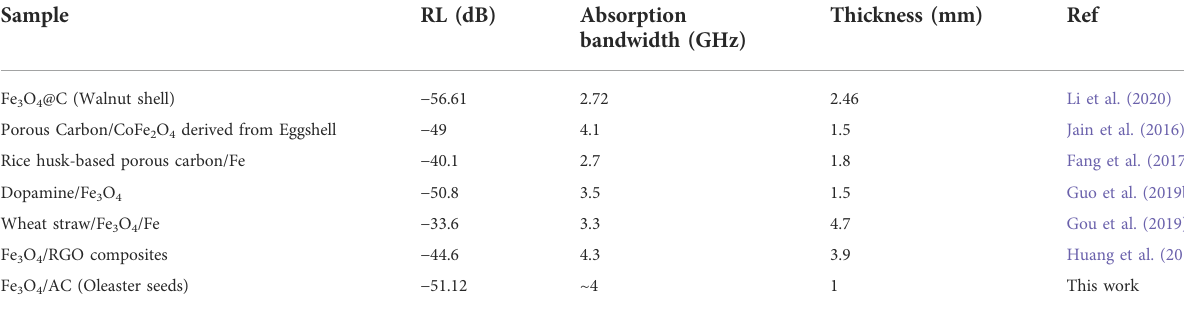
TABLE 4 Electromagnetic absorption performance of recently reported magnetic/carbon-based